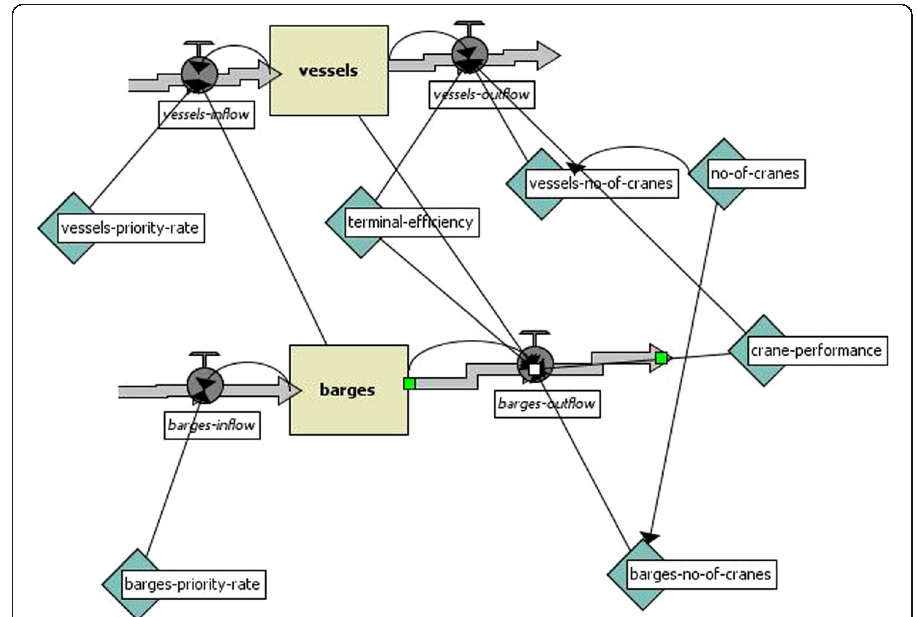
Fig. 4 Main outline of the Agent-Based